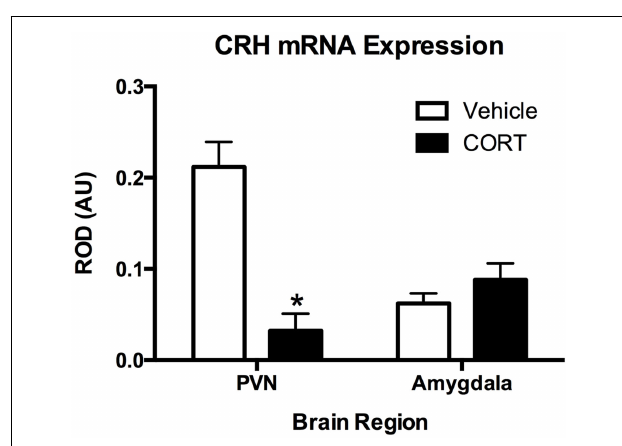
FIGURE 3 | Chronic low-dose CORT treatment reduced CRH mRNA expression in the PVN but does not affect expression in the amygdala . In situ hybridization showed that treatment with CORT (25 µ g/ml) in the drinking water for 4weeks resulted in a statistically significant decrease in CRH mRNA expression in the PVN, but not in the amygdala. Asterisk indicates statistically significant difference at the P < 0.05 level. treatment and brain region (two-way ANOVA, F 1,12 = 15.15.,